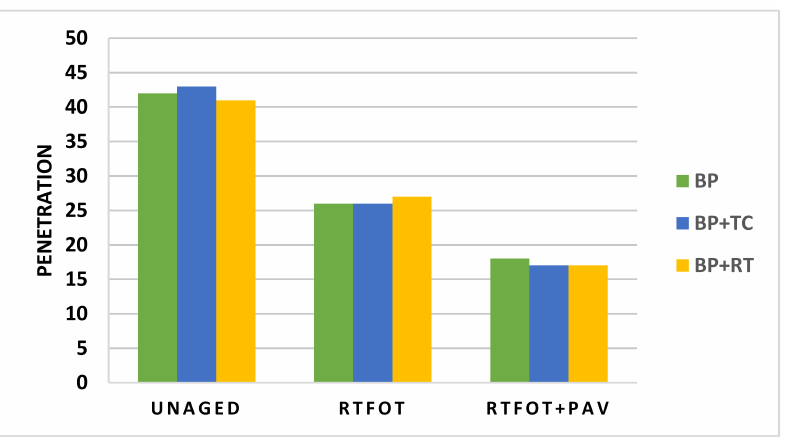
Figure 4. Penetration test results of all the samples at different ageing stages.